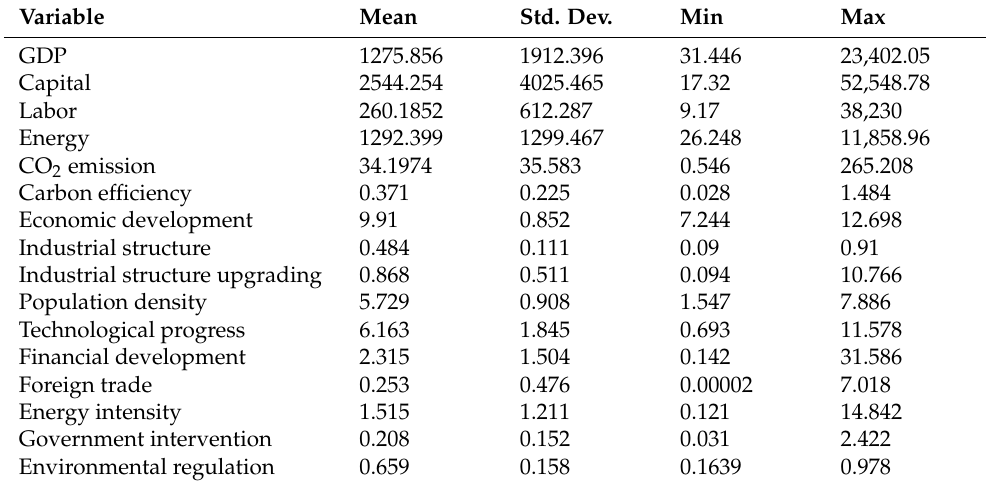
Table 1. Descriptive statistics of variables,